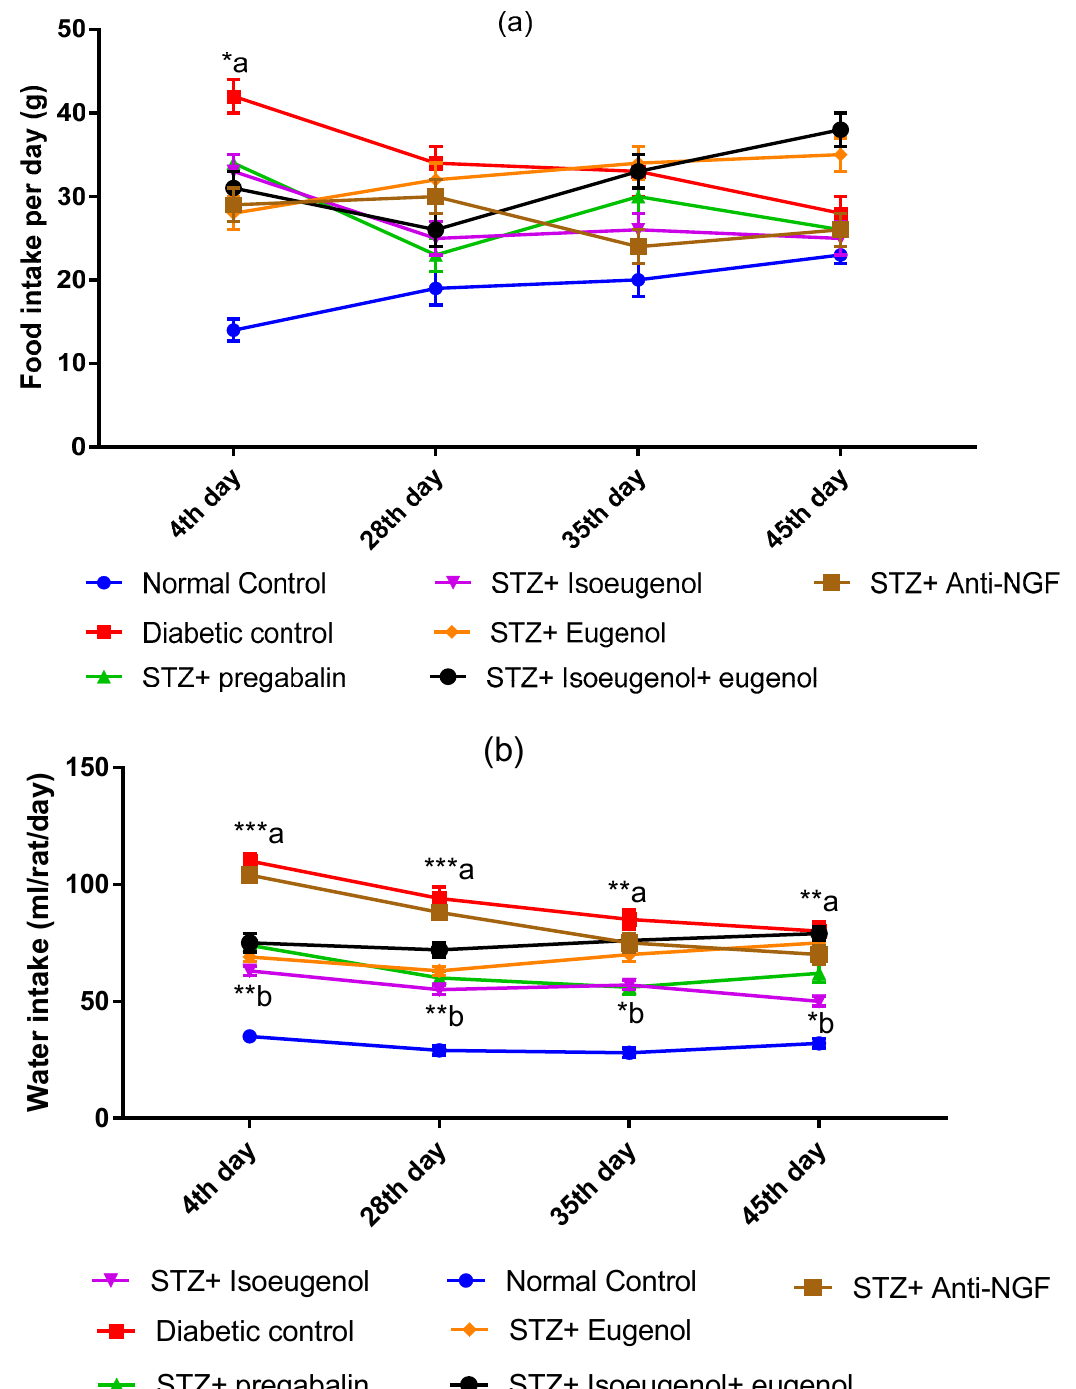
Figure 4. E ff ect of isoeugenol, eugenol, and their combination on ( a ) food and ( b ) water intake . A p < value of 0.05 was considered statistically signi fi cant. Signi fi cance is represented as * p < 0.05, ** p < 0.01, and *** p < 0.001; a—normal control versus diabetic control corresponding to the same day, b— diabetic control versus treatment groups corresponding to same day.